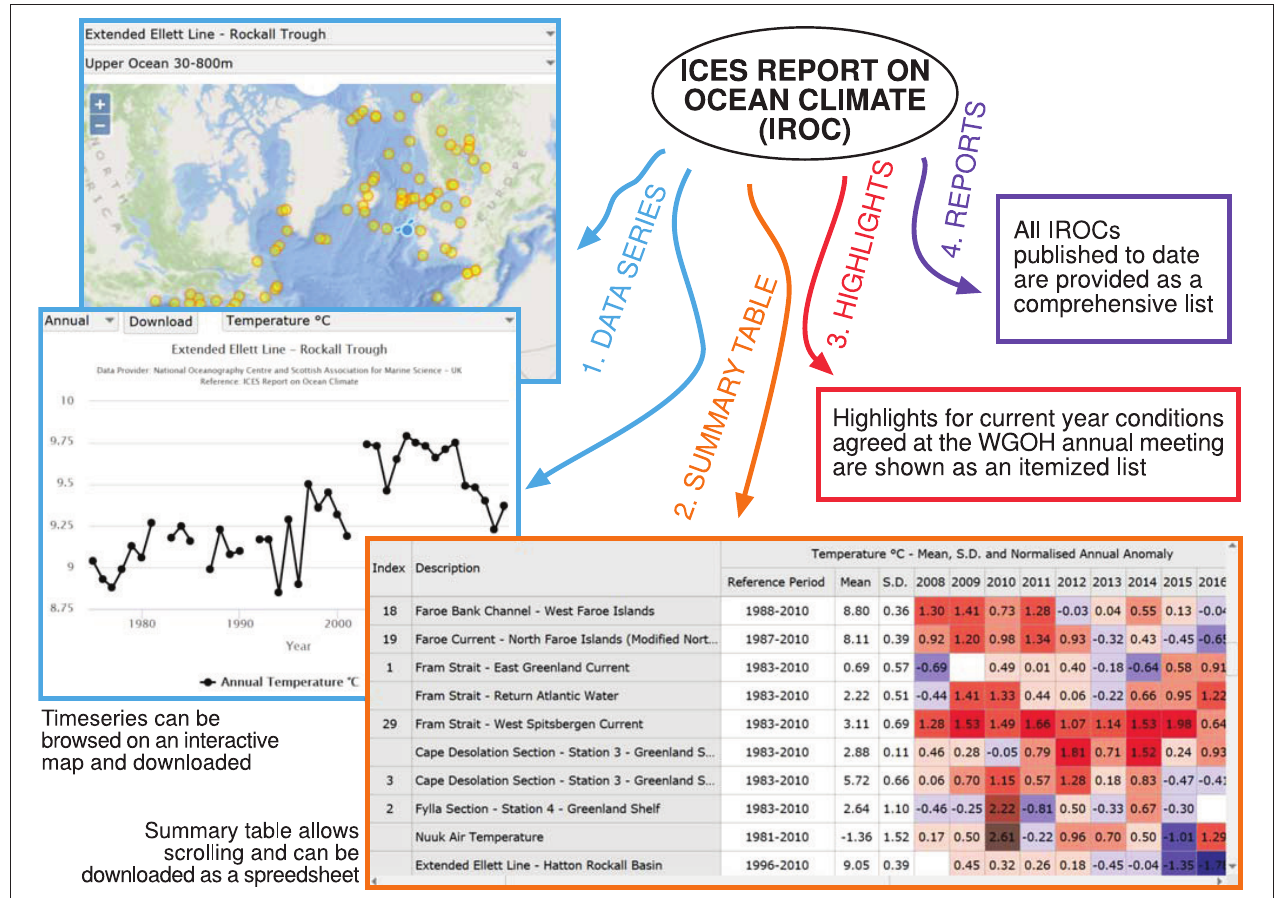
FIGURE 1 | Composite of content provided by the web version of the IROC report as of 2018. The portal is organized into four tabs containing data and elaborated information.